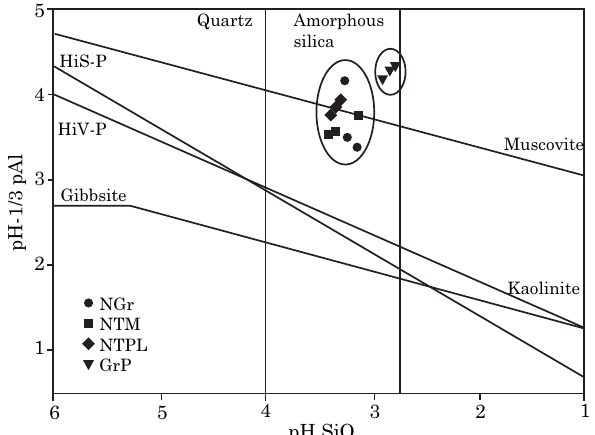
Figure 3. Stability diagram of minerals (HIS = smectite and HIV = vermiculite with partially occupied layers by Al hydroxy (-P) and representation of the soil composition in relation to the stability lines. NGr: native grassland; NTM: No-tillage maize cultivation without poultry litter application; NTPL: no-tillage cultivation with poultry litter; GrP: grazed native pasture with cattle